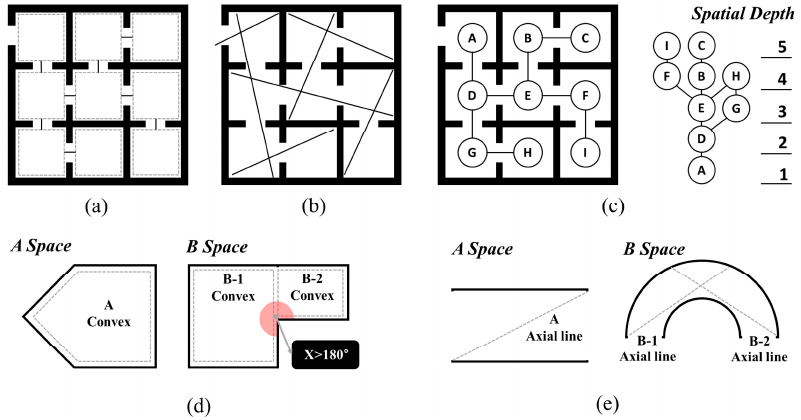
Figure 2. An example of a spatial analysis form: ( a ) convex space; ( b ) axial map; ( c ) J-Graph; ( d ) creating a convex space; ( e ) creating an axial map. Table 1. The interpretation of space–syntax